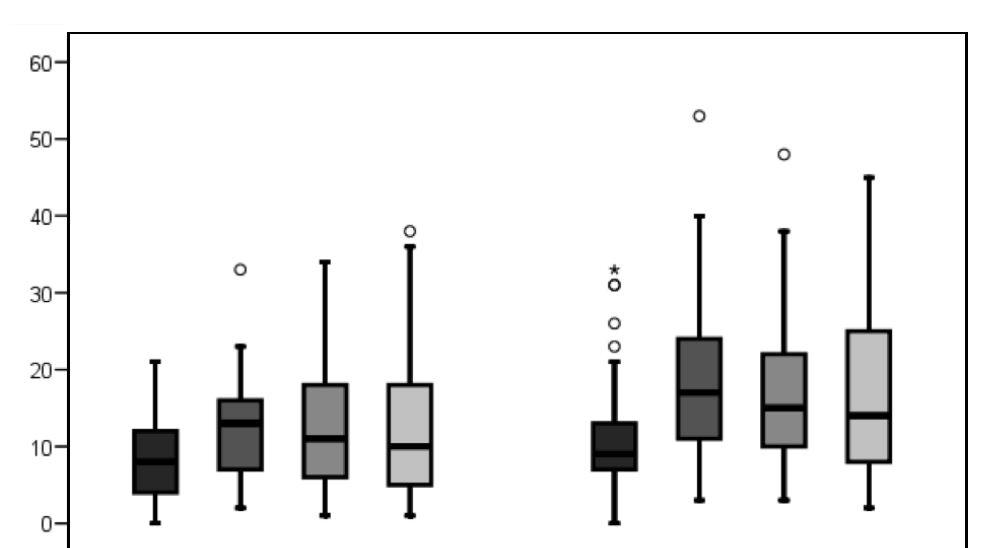
Fig. 1 - Statistical analysis of the Beck’s Depression Inventory and Beck’s Anxiety Inventory results.